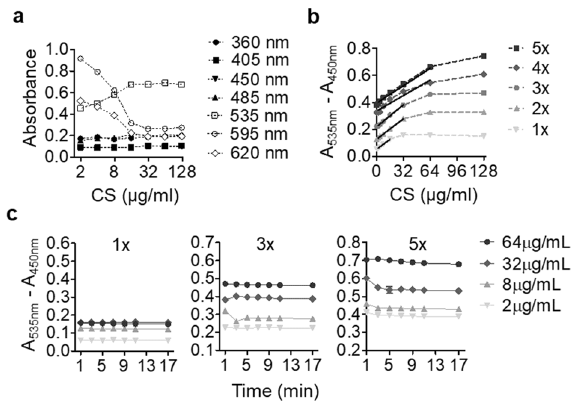
Figure 1. Optimizing GAG detection in a miniaturized DMMB assay. ( a ) Absorbance profile of the DMMB reaction with a range of chondroitin sulfate concentrations (CS, 2–1128 μg/mL). ( b ) Effects of different concentrations of DMMB reagent (1× refers to typical concentration) on the linear reading window. ( c ) Kinetics of the DMMB assay at specific concentrations of chondroitin sulfate using different concentrations of DMMB reagent. Data are expressed as the mean ± SEM from five independent